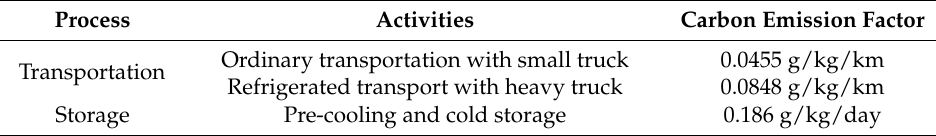
Table 3. The inventory carbon emission